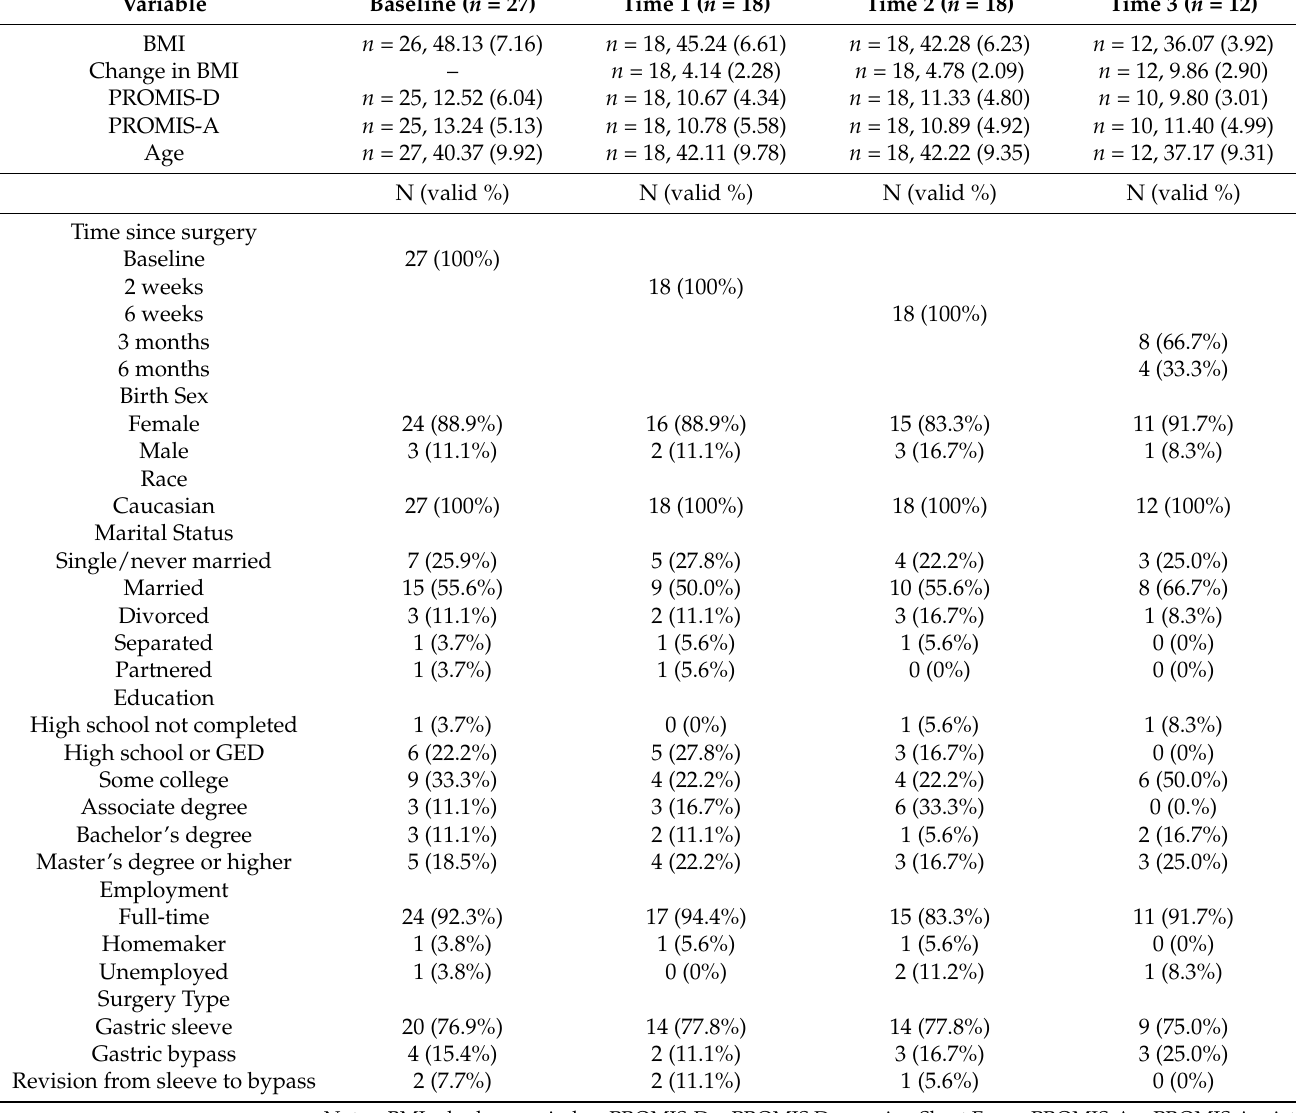
Table 1. Demographic and descriptive statistics by time